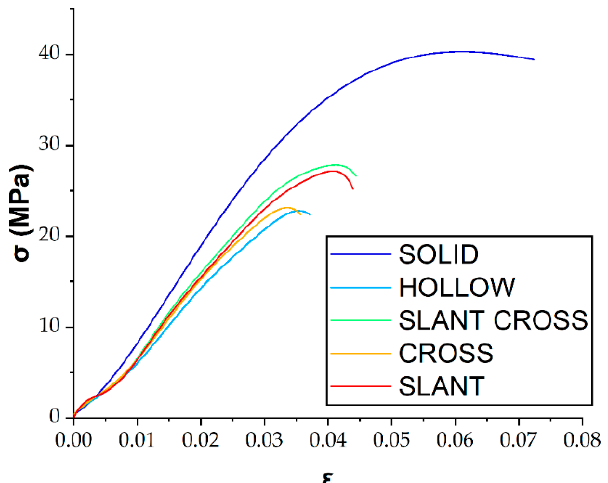
Figure 10. Tensile stress–strain curves of samples.